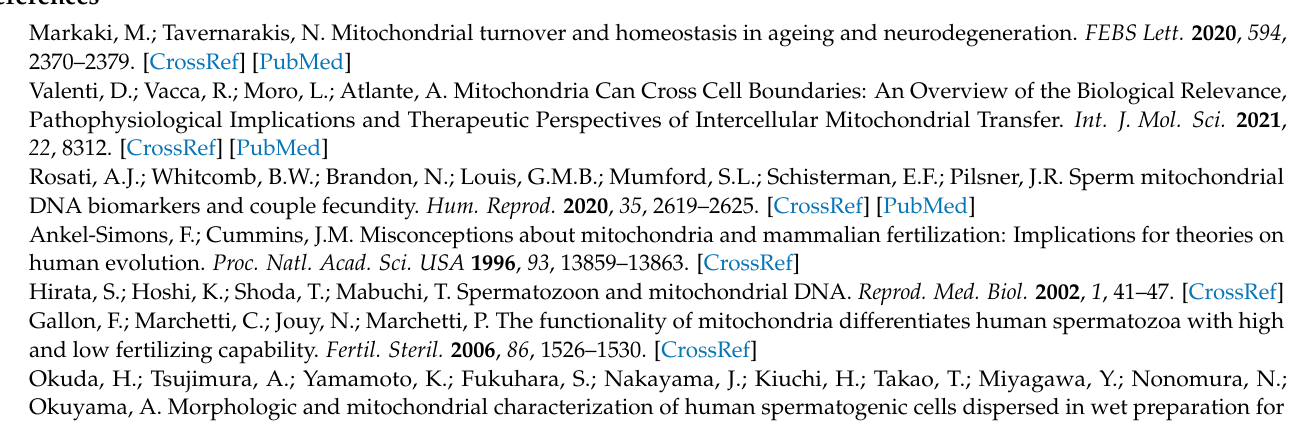
Table S5: Primer sequences used for the real-time PCR analysis of molecular markers of mitochondrial autophagy. Table S6: Primer sequences used for the real-time PCR analysis of molecular markers of mitochondrial functionality. Table S7: Primer sequences used for the real-time PCR analysis of cAMP signaling elements. Table S8: Primer sequences used for the real-time PCR analysis of MAPK signaling elements. Table S9: The characteristics of the